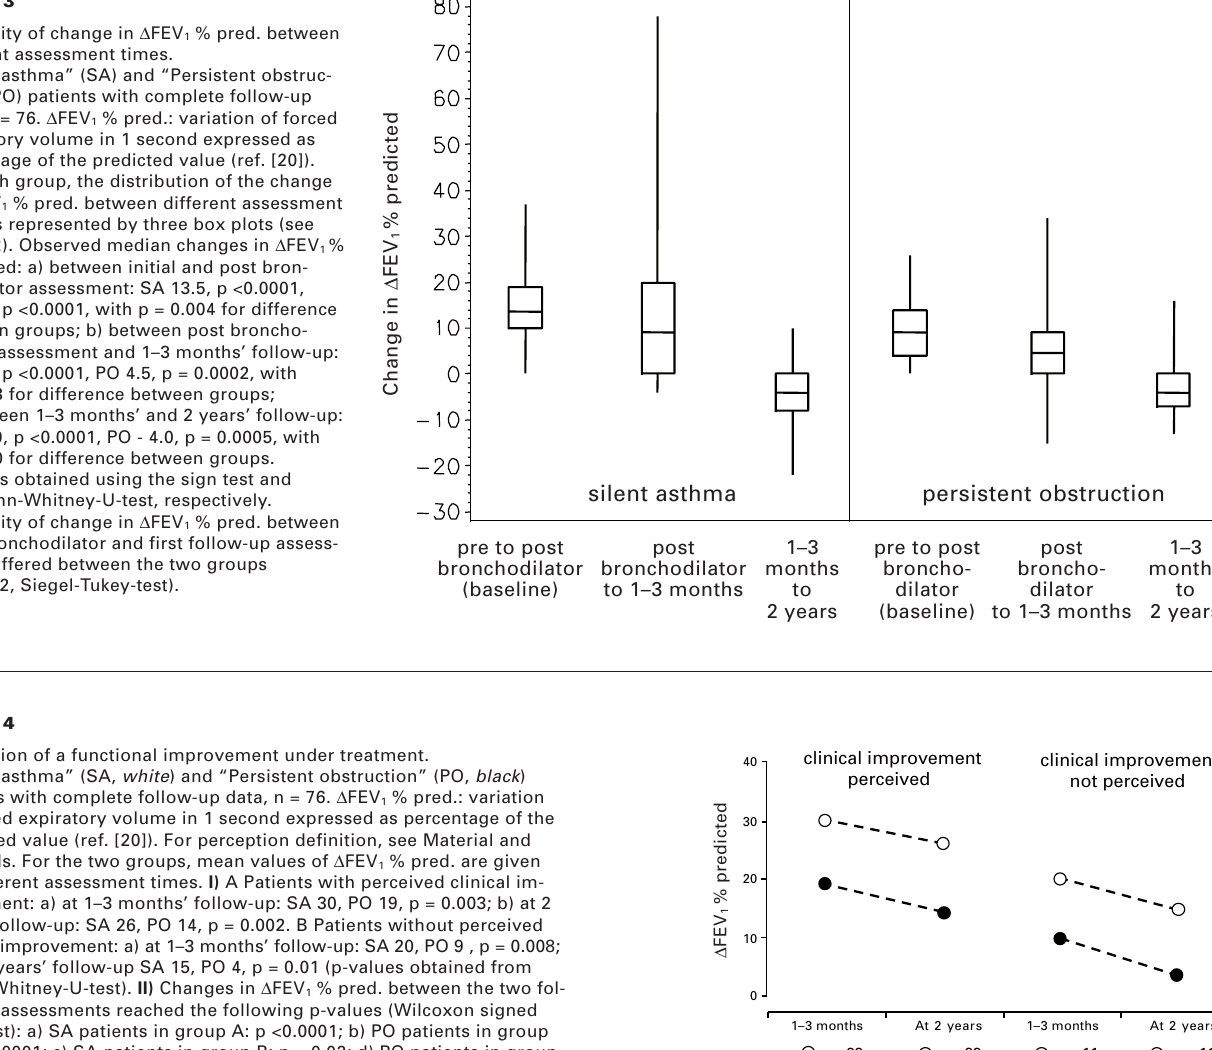
Perception of a functional improvement under treatment. “Silent asthma” (SA, white) and “Persistent obstruction” (PO, black) patients with complete follow-up data, n = 76. D FEV 1 % pred.: variation of forced expiratory volume in 1 second expressed as percentage of the predicted value (ref. [20]). For perception definition, see Material and Methods. For the two groups, mean values of D FEV 1 % pred. are given for different assessment times. I) A Patients with perceived clinical im- provement: a) at 1–3 months’ follow-up: SA 30, PO 19, p = 0.003; b) at 2 years’ follow-up: SA 26, PO 14, p = 0.002. B Patients without perceived clinical improvement: a) at 1–3 months’ follow-up: SA 20, PO 9 , p = 0.008;